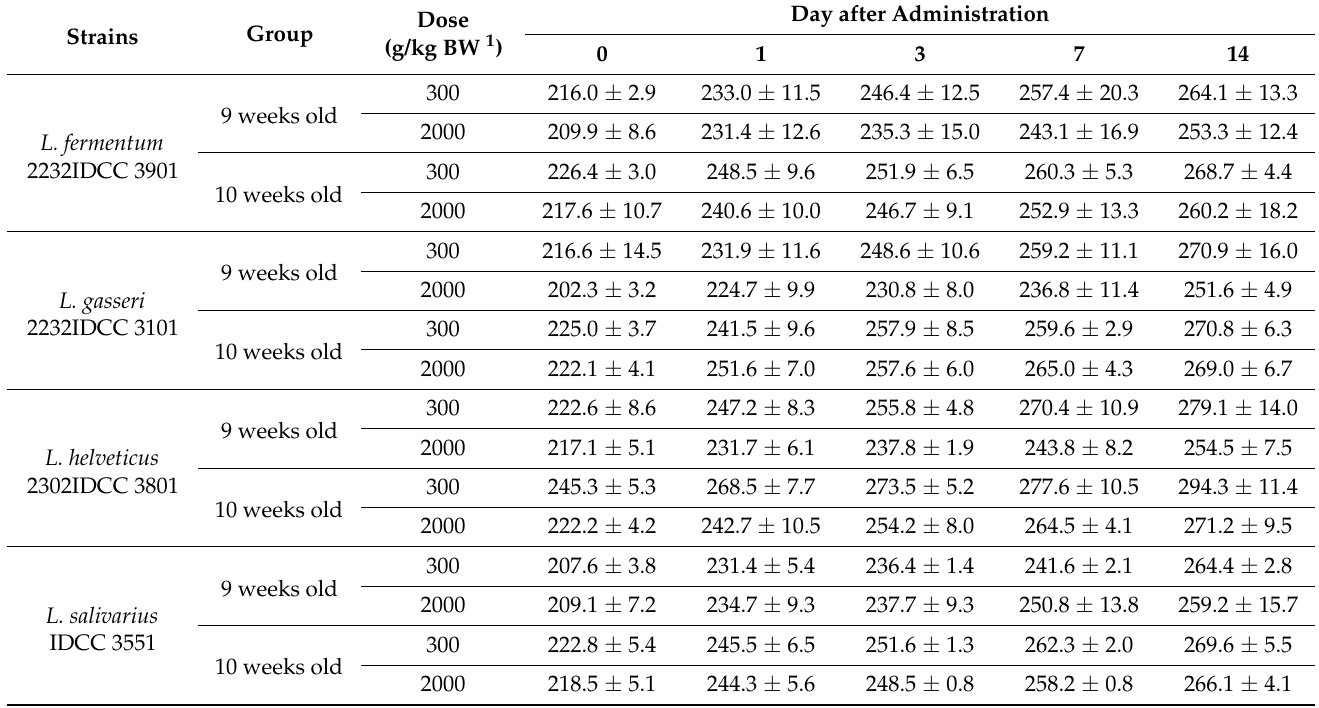
Table 7. Body weight changes of rats administered the four Lactobacillus